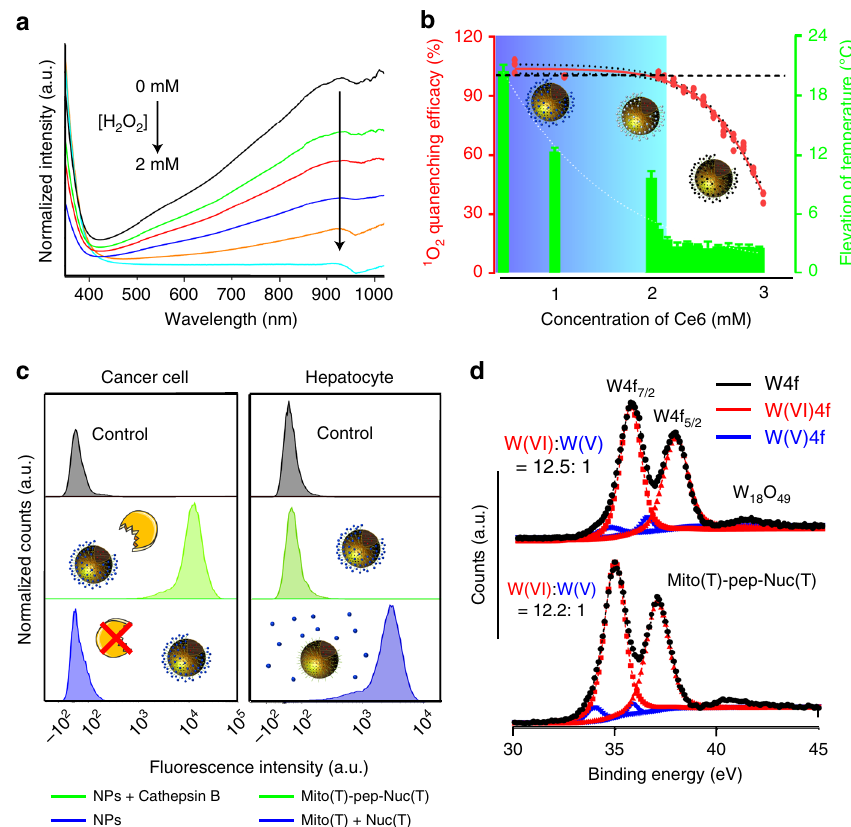
Fig. 2 Optimization of the composition. a UV – vis – NIR spectra of the WONPs suspension post the addition of different amounts of H 2 O 2 . The oxidation of WONPs into WO 3 was re fl ected in real-time by the loss of the characteristic peak at 930 nm. b The ef fi cacy of WONPs at a fi xed concentration (2.4 × 10 16 particles per mL) in eliminating singlet oxygen generated from Ce6 that differed in amount. The temperature elevation of the suspension was measured right after the second-round laser irradiation. Data are presented as mean ± s.e.m. ( n = 3). The cartoons inserted in the image illustrate the changes of WONPs that were partially (middle) to entirely oxidized (right). c The level of intracellular ROS measured using the H 2 DCFDA probe. For cancer cells, they were all incubated with Mito(T)-pep-Nuc(T), and the only difference is the enzymatic activity of Cathepsin B (normal: NPs + Cathepsin B; inhibited: NPs). For hepatocytes, they were incubated with either Mito(T)-pep-Nuc(T) or a mixture of Mito(T) and Nuc(T) under an identical condition. d The XPS spectra of tungsten element in Nuc(T) of Mito(T)-pep-Nuc(T) at Day 4 post their incubation with mouse serum at 37 °C. The plot was deconvoluted to show the proportions of both W(V) and W(VI) species. The pro fi les of pristine WONPs served as control and was shown for